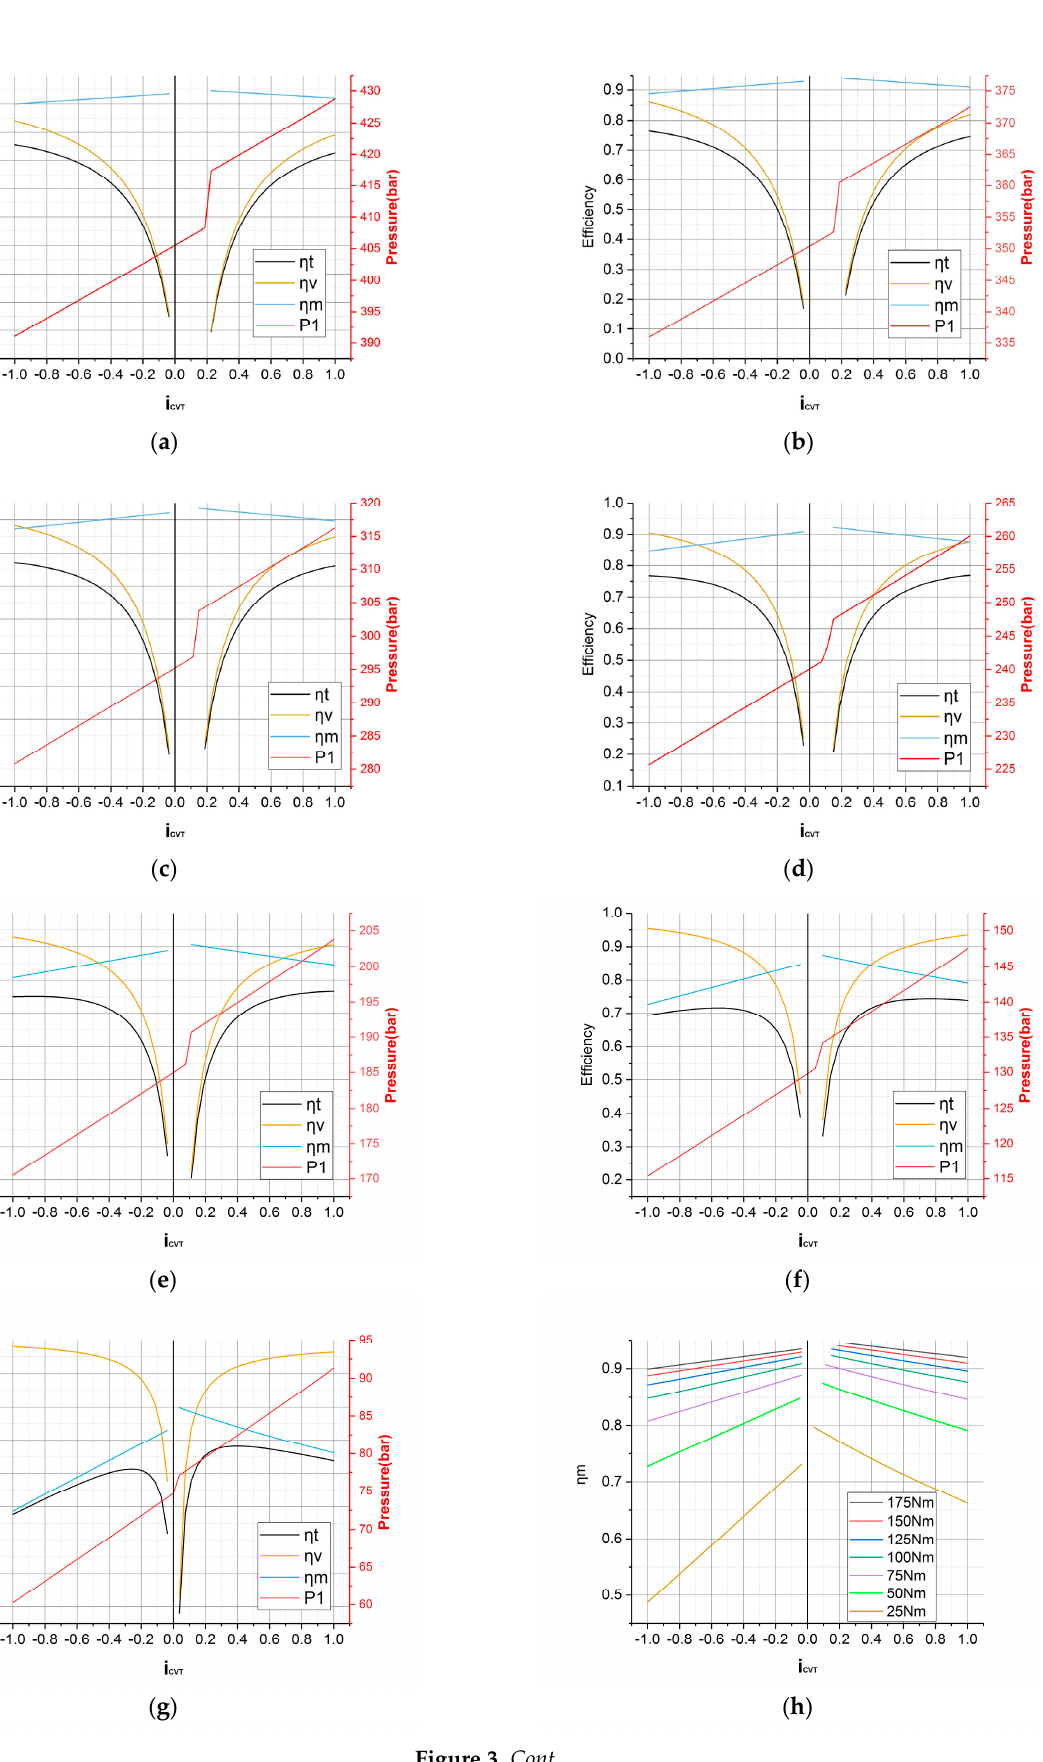
( j ) Figure 3. Analysis results of hydrostatic CVT: ( a ) 𝑇 (cid:3014) = 175 N ∙ m ; ( b ) 𝑇 (cid:3014) = 150 N ∙ m ; ( c ) 𝑇 (cid:3014) = 125 N ∙ m ; ( d ) 𝑇 (cid:3014) = 100 N ∙ m ; ( e ) 𝑇 (cid:3014) = 75 N ∙ m ; ( f ) 𝑇 (cid:3014) = 50 N ∙ m ; ( g ) 𝑇 (cid:3014) = 25 N ∙ m ; ( h ) Mechanical efficiency 𝜂 (cid:3040) ; ( i ) Volumetric efficiency 𝜂 (cid:3049) ; ( j ) Total efficiency 𝜂 (cid:3047) .